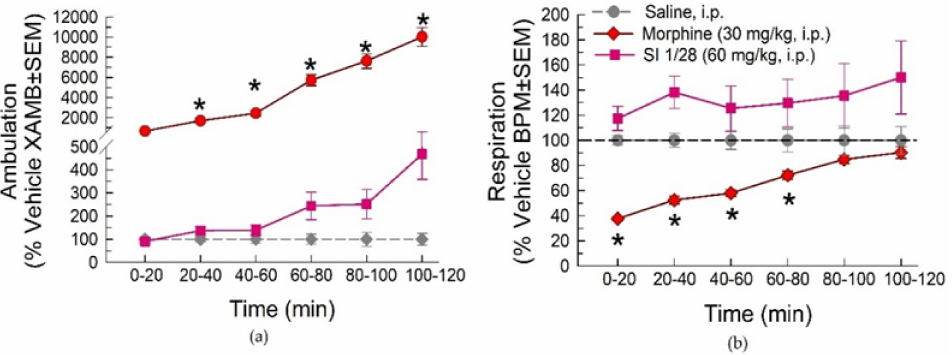
Figure 5. Dose- and time-dependent ( a ) spontaneous ambulation and ( b ) respiratory effects of morphine (30 mg/kg, i.p.; red circles) or SI 1/28 (60 mg/kg, i.p.; pink squares) evaluated in the CLAMS/Oxymax system with C57BL6/J mice. * = significantly greater than vehicle effect (gray dashed line), p < 0.05; two-way ANOVA w/Dunnett’s post hoc test. n = 12 mice/group. Data presentenced as % vehicle response ± SEM; ambulation, XAMB ( a ) or breaths per minute, BPM ( b ). Changes in evoked or sedative-like effects were evaluated using the rotarod appa- ratus. The KOR agonist, U50,488, impaired locomotion compared to saline (treatment: F (3, 259) = 34.7, p < 0.0001 and time: F (6, 259) = 3.04, p = 0.0068, Two-way RM ANOVA with Dunnett’s post hoc test; Figure 6). However, neither the 45 or 60 mg/kg (i.p.) doses of SI 1/28 impaired evoked locomotion or produced sedative-like effects as compared to the vehicle control ( p >